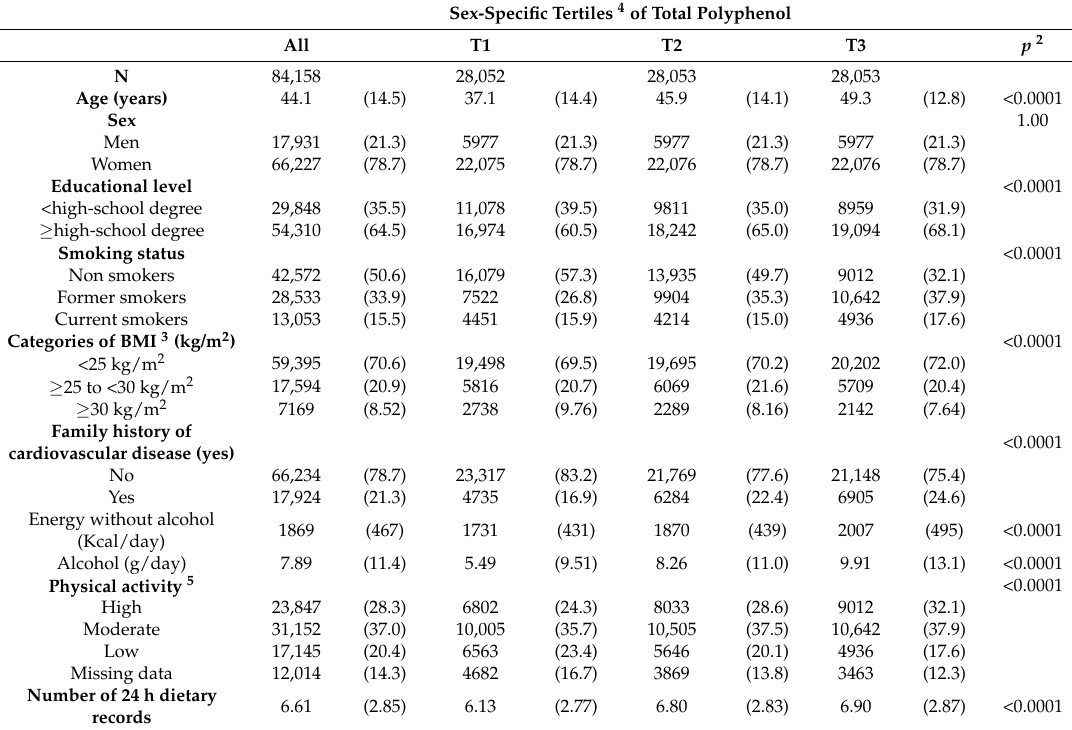
Table 2. Baseline characteristics 1 of the study population overall and according to tertiles of dietary intake of total polyphenols, NutriNet-Sant é Cohort, France,